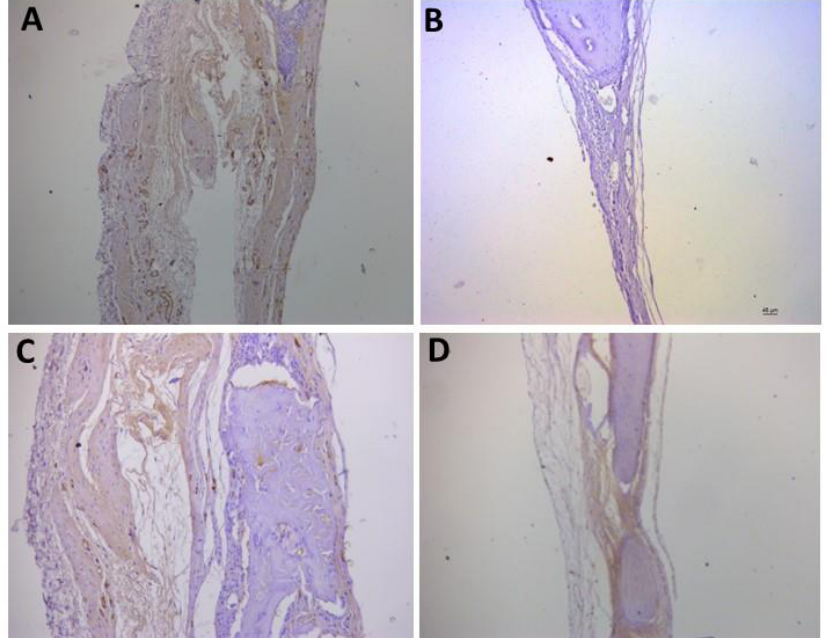
Figure 3. Representative immunohistochemistry images for CD31 staining. ( A ) control group; ( B ) negative control; ( C ) group 2 with marking considered (+); ( D ) group 6 with marking considered (+); the most observed staining pattern among the groups analyzed. Harris ’ hematoxylin counterstained. Scale bar: 46 µm.